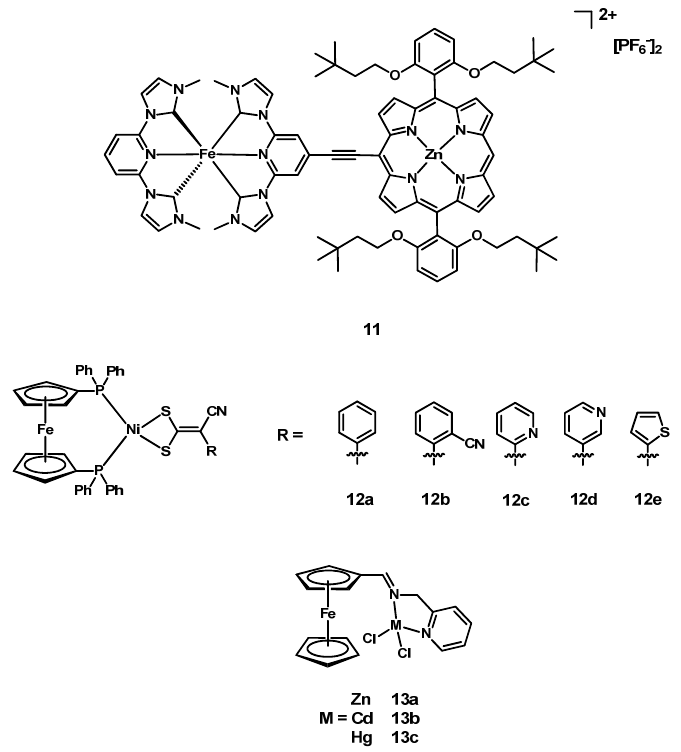
Figure 6. Structure of dyes 11 , 12a – e, and 13a – c . The UV–Vis spectrum of ACN showed a strong absorption band between 400 and Table 3. Photovoltaic data of DSSCs produced with dyes 11 , 12a – e , and 13a – c 1 . 450 nm, with a molar extinction coefficient exceeding 10 5 M − 1 cm − 1 , and a weaker band between 600 and 650 nm. From the potentiometric characterization it emerged that the redox potentials of 11 were − 1.15 V for the zinc porphyrin and +0.76 V for the couple